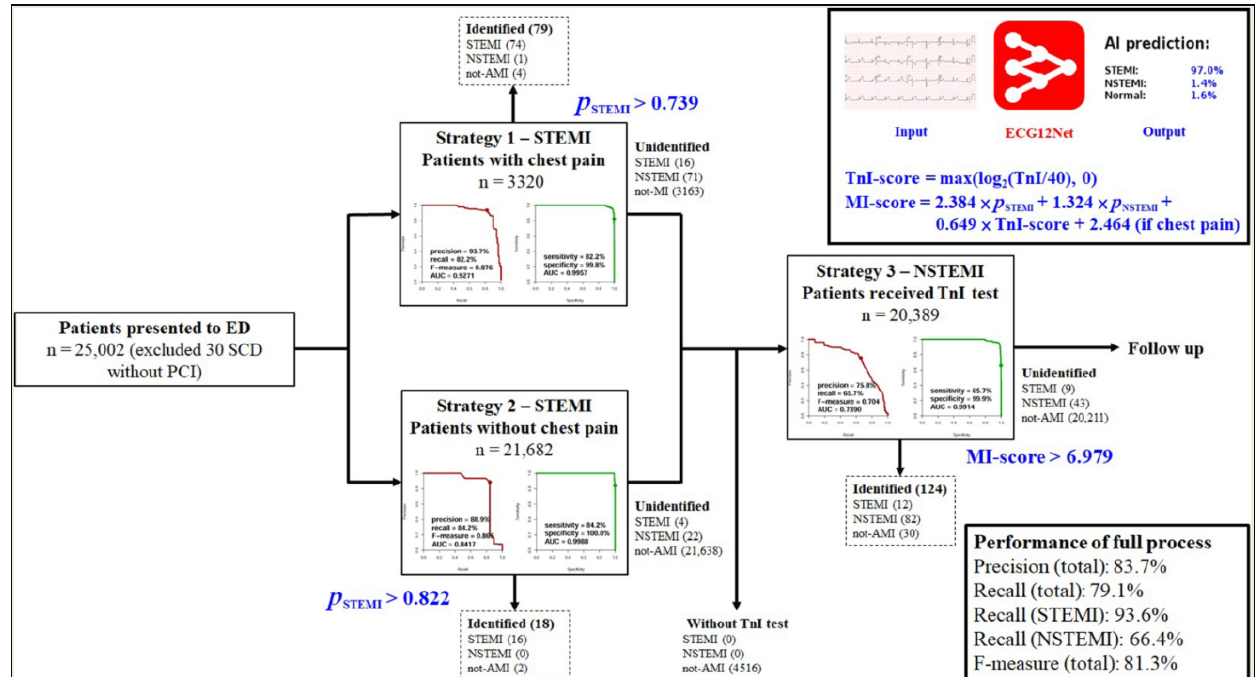
Figure 1. The workflow and development of the AI-based alarm strategy. All visits were divided into two groups with or without chest pain for STEMI detection. The remaining visits with hsTnI were used for subsequent NSTEMI detection. The AUROC curve and PRROC curve were generated by the highest probability of STEMI/NSTEMI prediction by our AI and hsTnI.